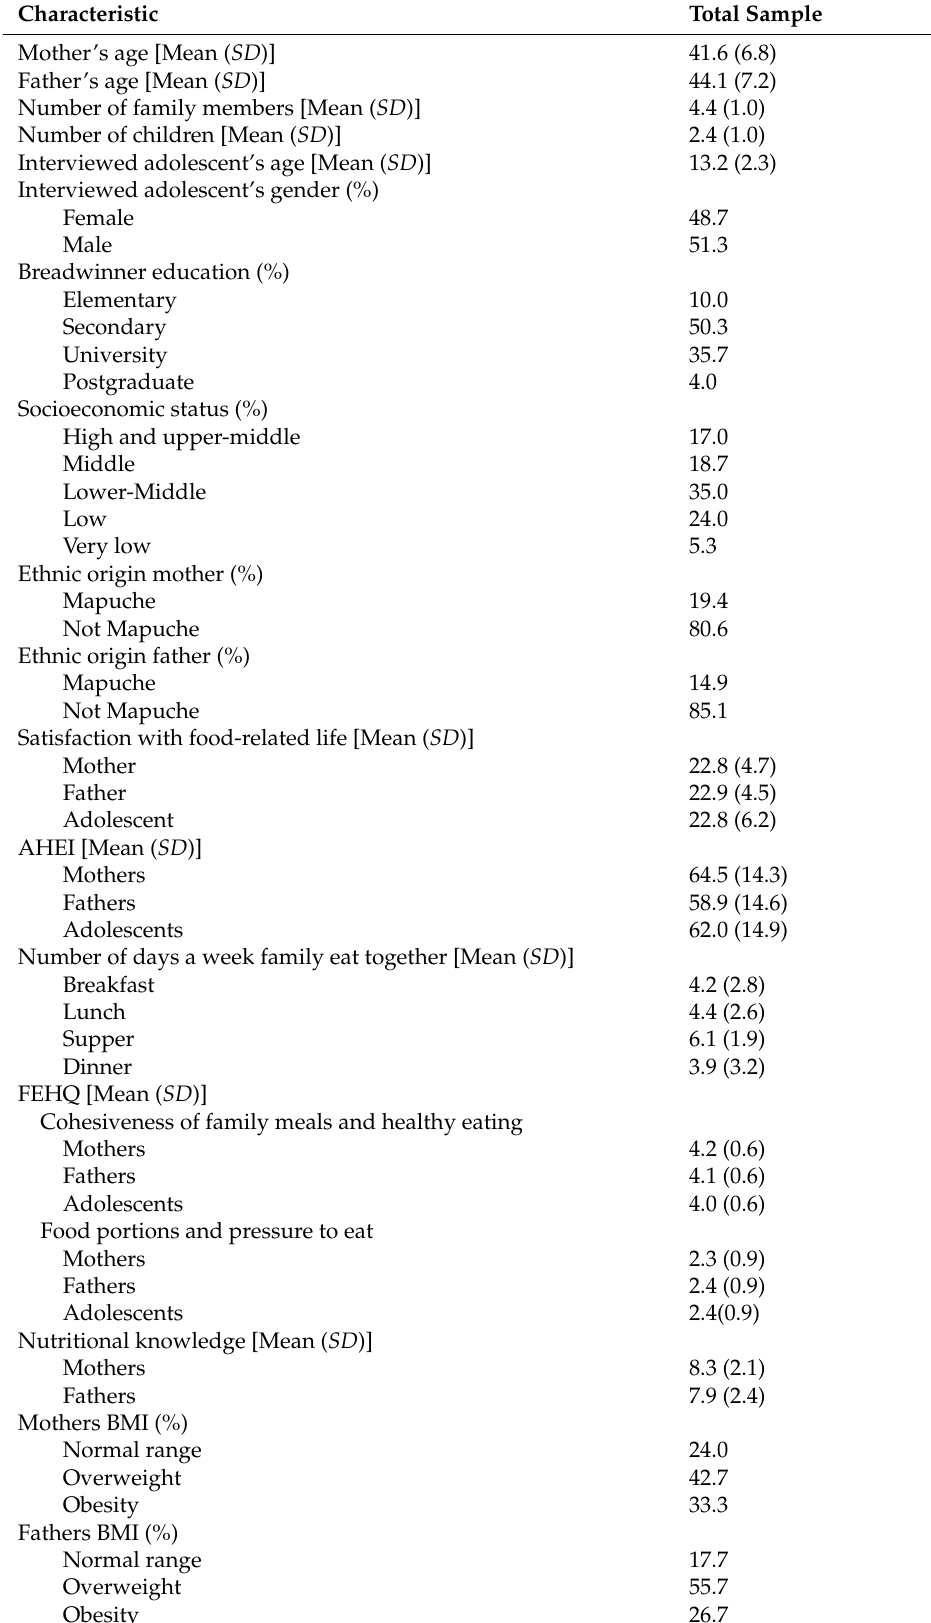
Table 1. Sample characteristics ( n =